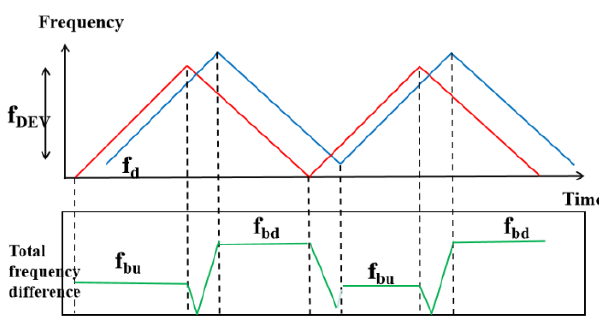
Figure 10. Frequency deviation on FMCW chirp on human motion.